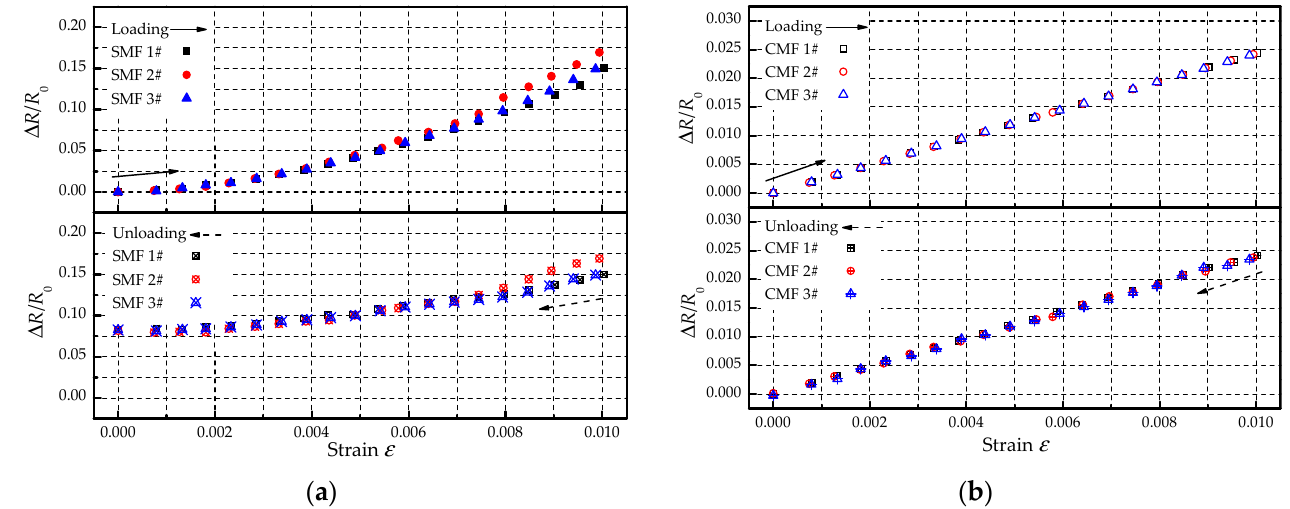
Figure 14. Variation of electric resistance during the loading-unloading process: ( a ) SMF; ( b ) CMF.